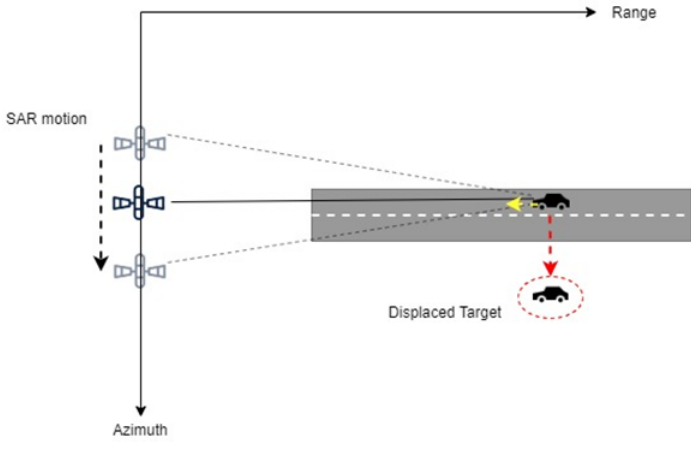
ff ect in cross-track motion of vehicles. Figure 5. Displacement effect in cross-track motion of vehicles. Figure 5. Displacement e